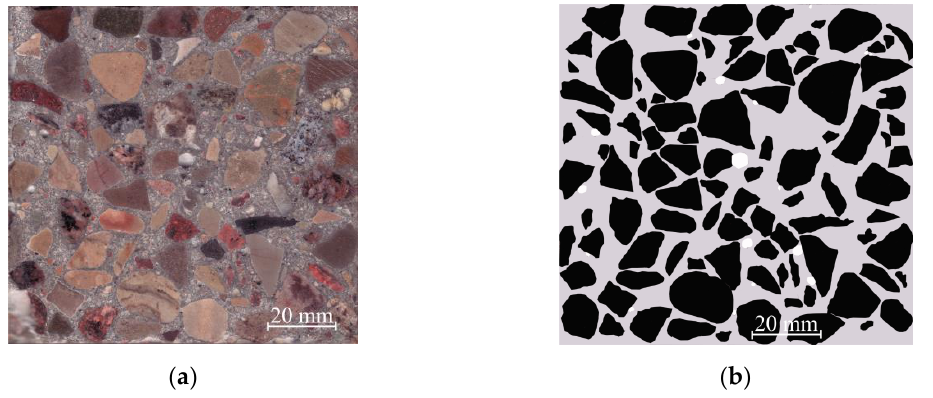
Figure 6. View of the concrete sample CW0, ( a ) scanned; ( b ) analyzed by employing computer graphic software: a white color is used to indicate pores; light gray—newly created cement stone with fine software: a white color is used to indicate pores; light gray — newly created cement stone with fine aggregate; black—coarse aggregate; black — coarse aggregates.